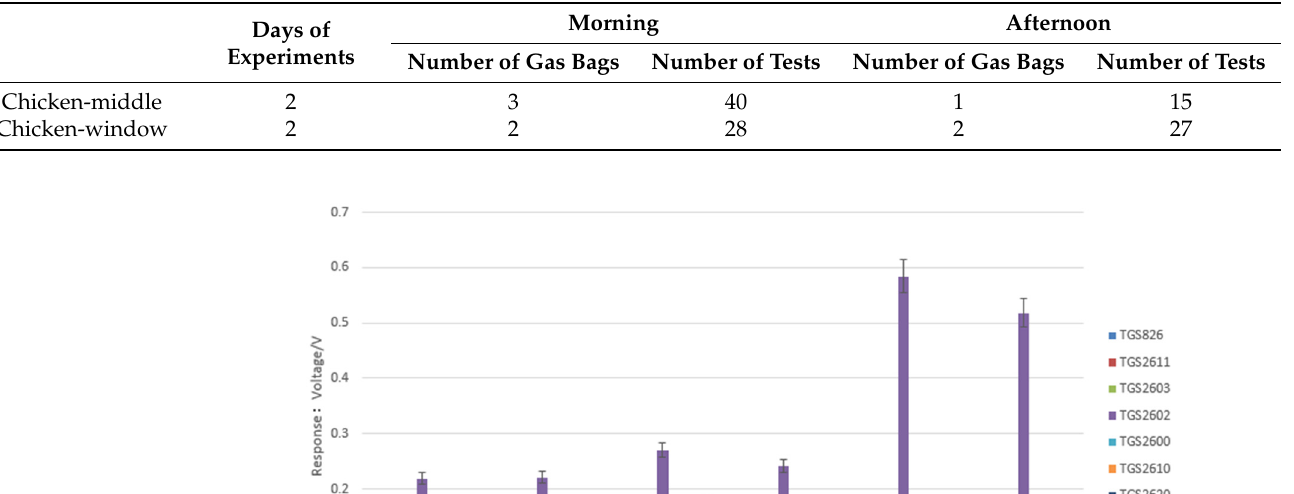
Table 3. Gas sample information and number of electronic nose tests for chicken house.